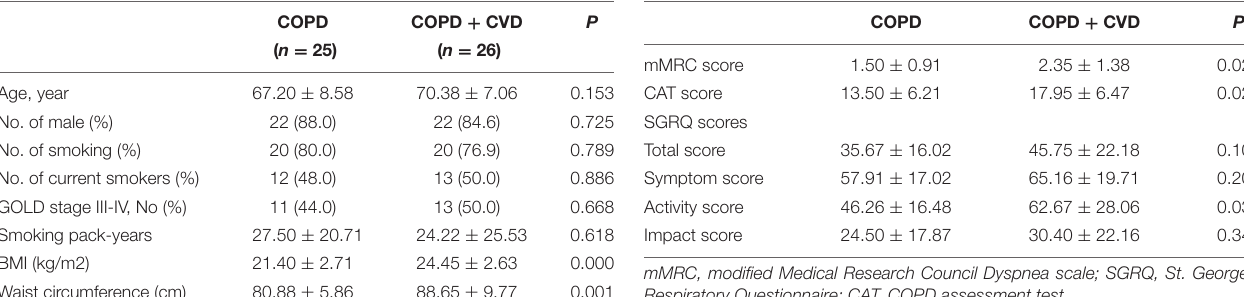
TABLE 1 | Demographics between two groups. TABLE 2 | Clinical characteristics between two groups.